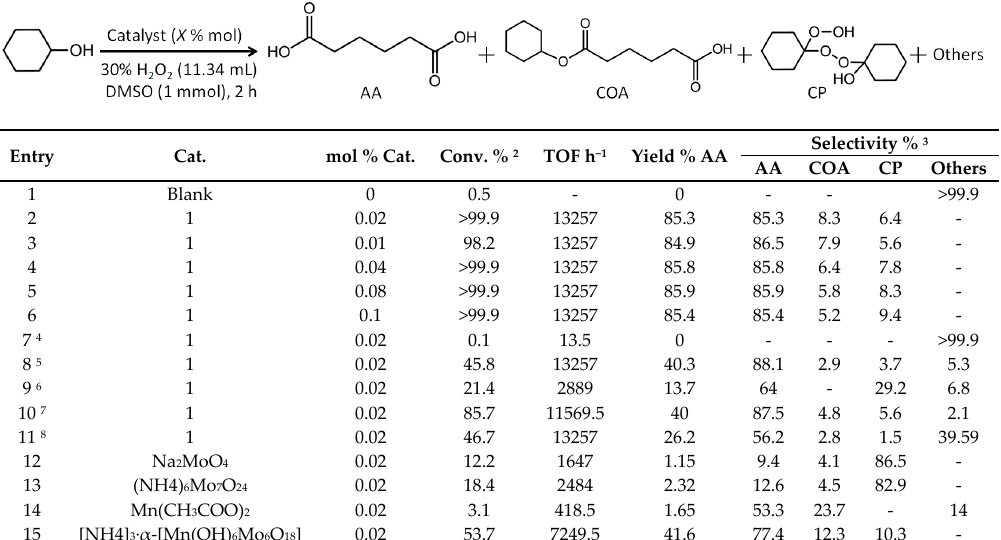
Table 2. Cyclohexanol oxidation with H 2 O 2 over catalysts. 1